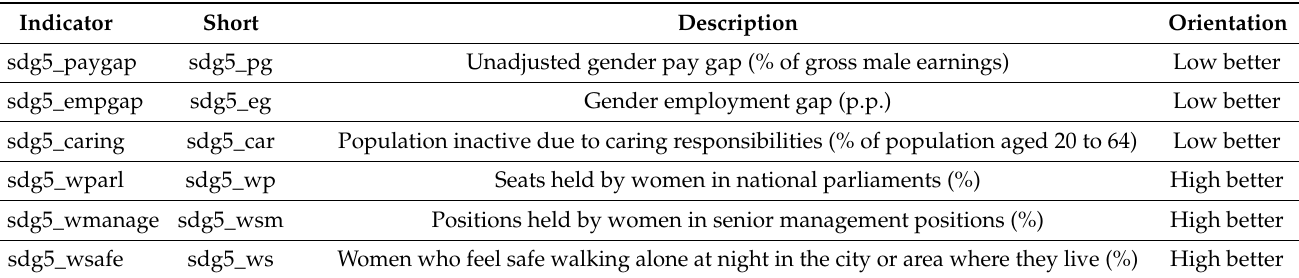
Table 6. Main indicators for disclosing gender equality.